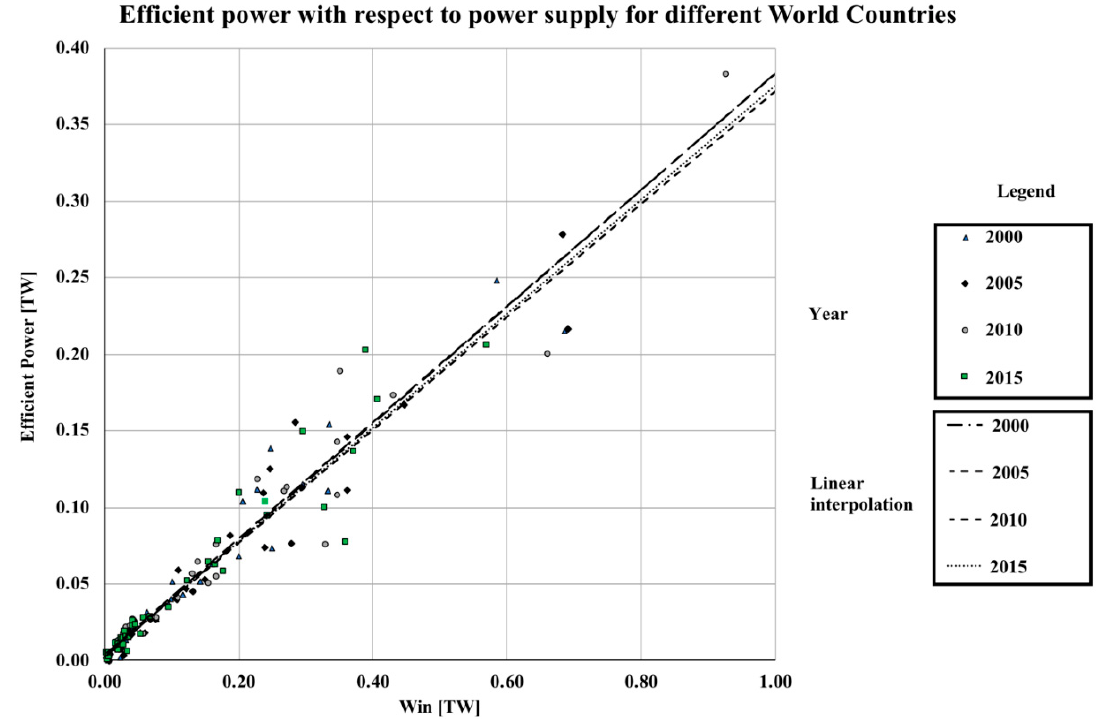
Figure 5. Efficient power consumption, in terawatt, with respect to input power, in terawatt, at Country level. Data source: IEA. Data refer to years 2000, 2005, 2010 and 2015. Each point represent a Country. The year tendency line indicates the existence of a linear relation between power input and efficient power consumption, with a high level of correlation between the two variables (R 2 = 0.99). Note that year 2000 and year 2005 tendency lines are almost superimposed .